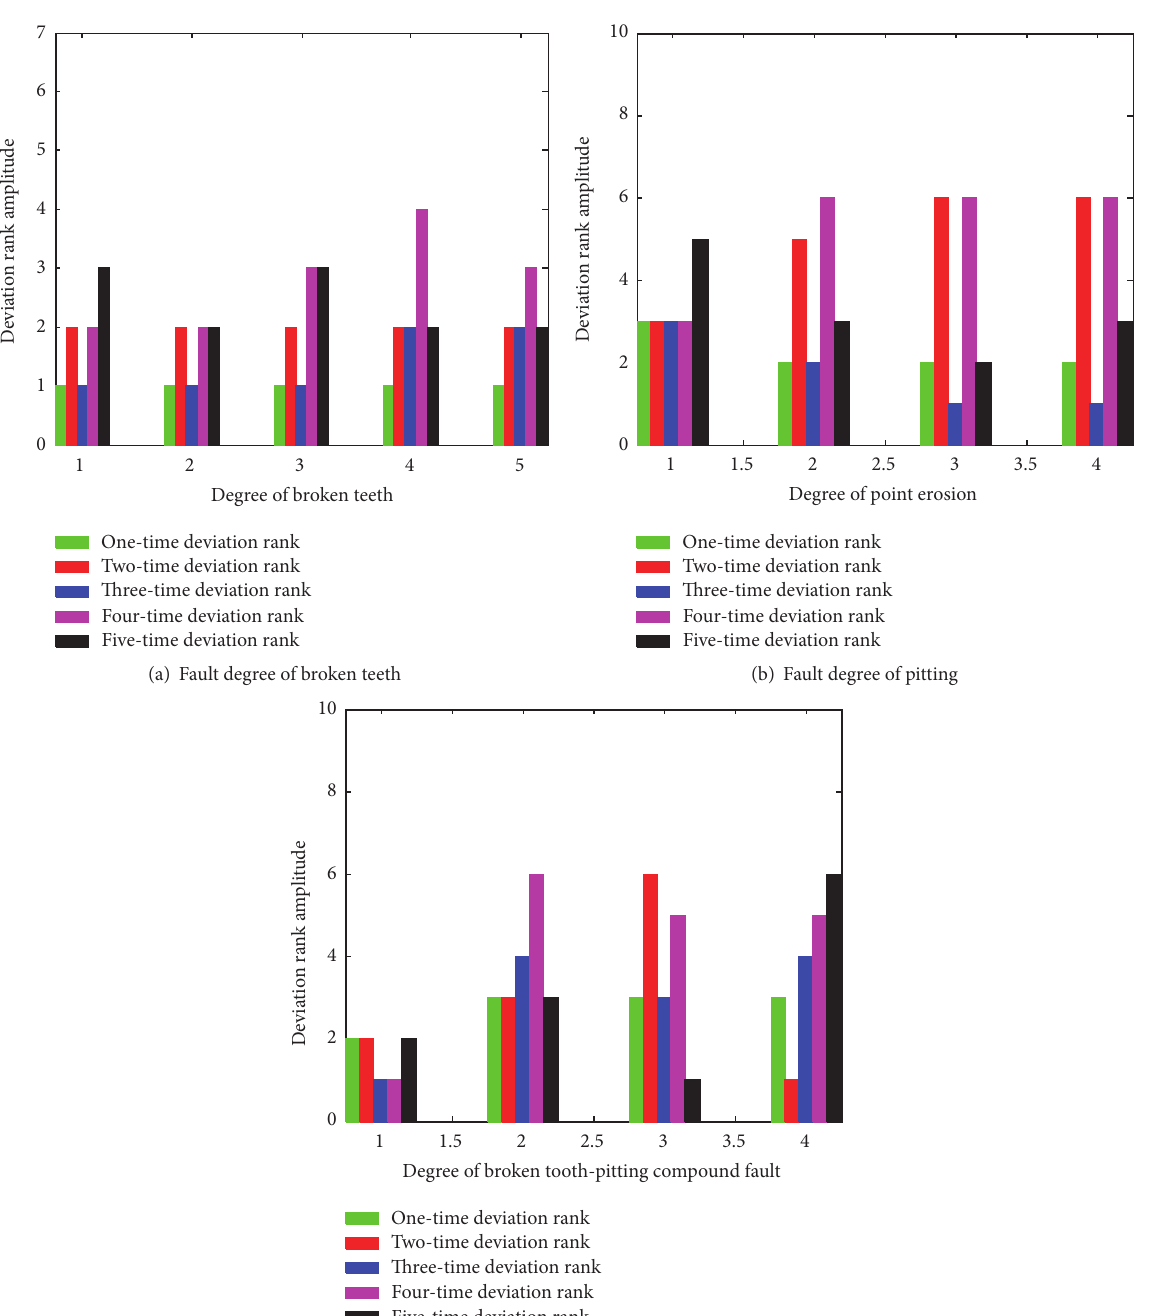
Figure 8: The relationship of absolute deviation rank between different fault degree and magnitude.